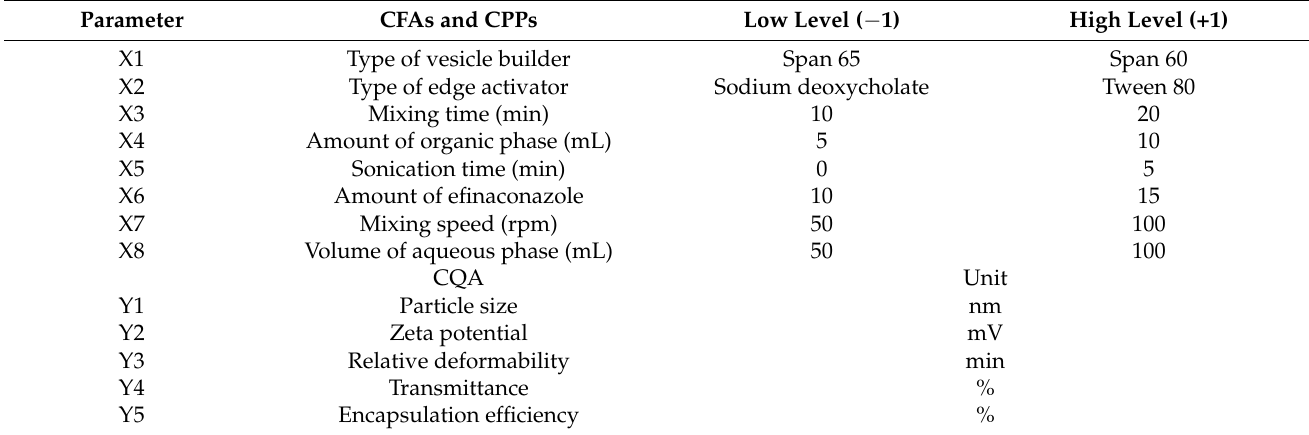
Table 1. Various CFAs and CPPs named as X 1 –X 8 along with their levels selected for 12-run PBSD analysis and the measured critical quality attributes (CQA; dependent variables Y 1 –Y 5 ).